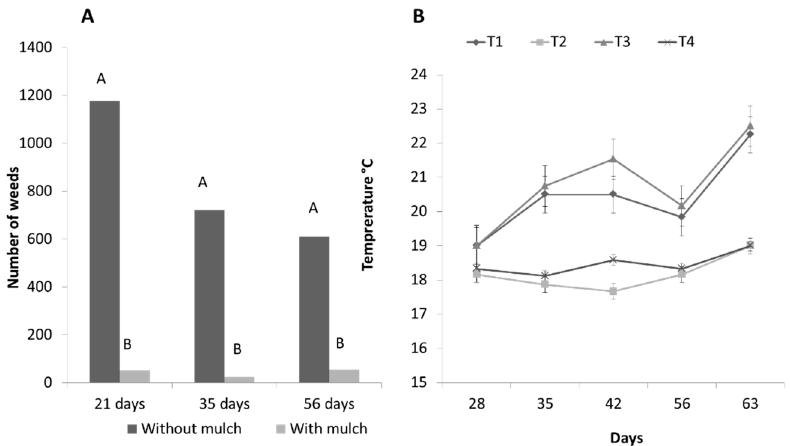
Figure 5. ( A ) Number of weeds per square meter (w/m 2 ) in beds with and without mulching at 21, 35, and 56 days post-transplant of pepper; different letters in the column indicate significant differences between treatments (Tukey-HSD, α = 0.05). ( B ) Effect of the mulching on soil temperature at 28, 35, 42, 56, and 63 days; points express the average of three replicates and the bars the standard deviation.